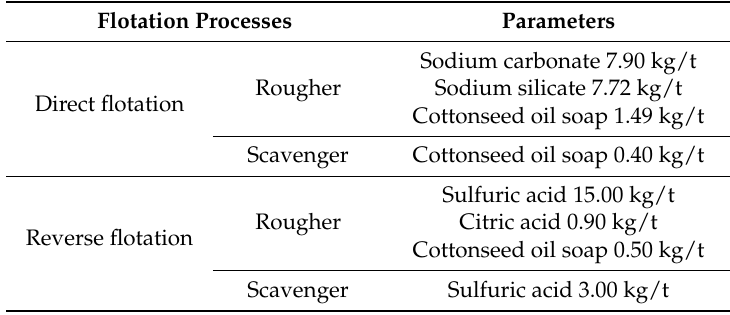
Table 8. Flotation parameters in a closed circuit flotation experiment.